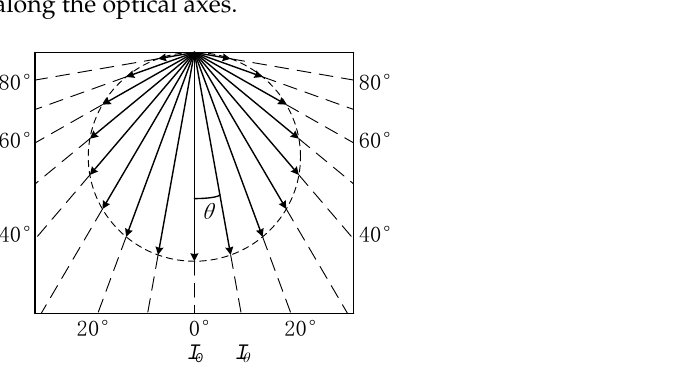
Figure 1. Schematic diagram of normalized luminous intensity of the standard Lambertian light source.